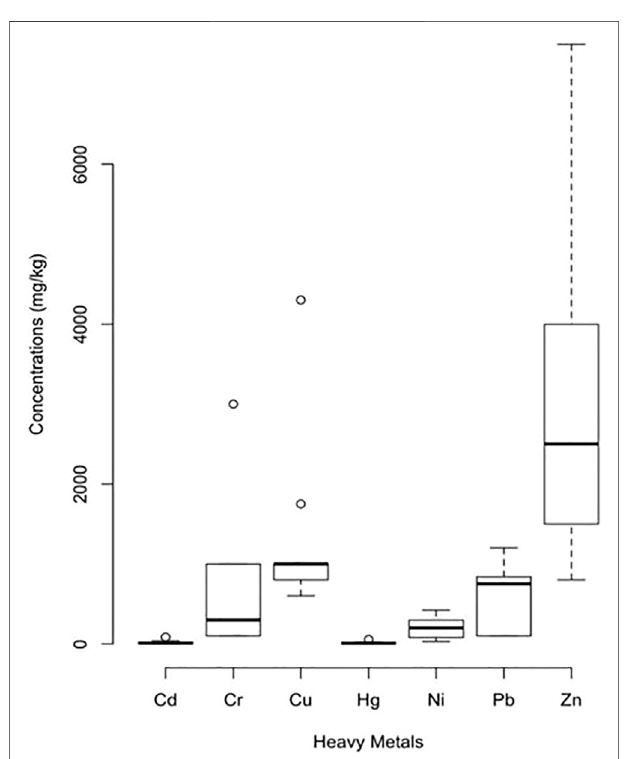
FIGURE 4 | Maximum metal concentrations in SS for an agricultural use (mglKg) [Data are derived from Agence Nationale pour la Rkcupkration et 1 ’ ~limination des Dkchets, 1988; UK Statutory Instruments (1989); Berg et al. (1993); U.S. Environmental Protection Agency (1993)]; (Page, 1994).